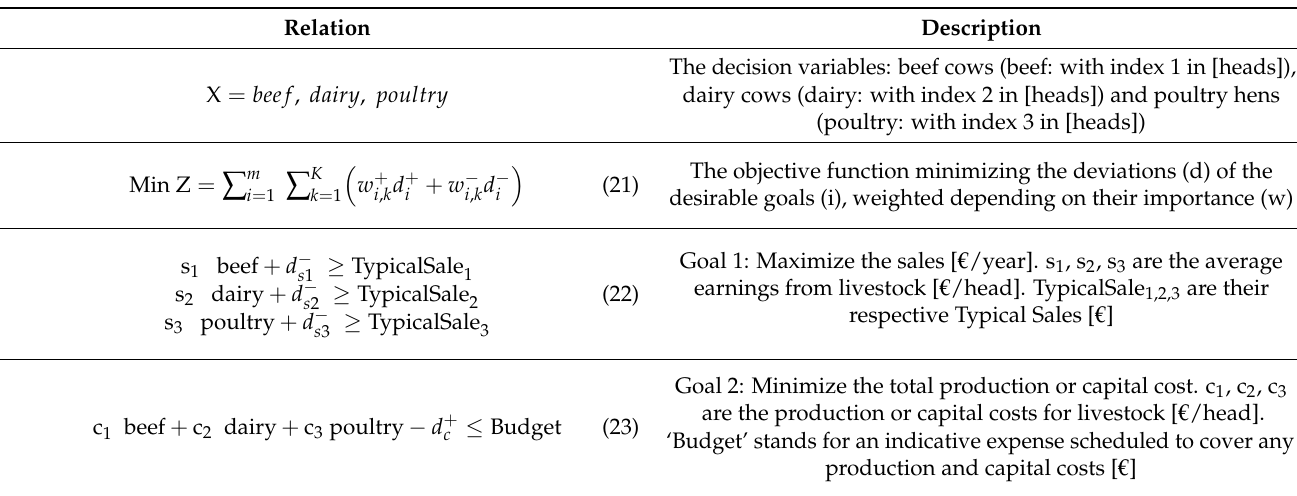
Table 3. Mathematical description of the ESCA model (annual